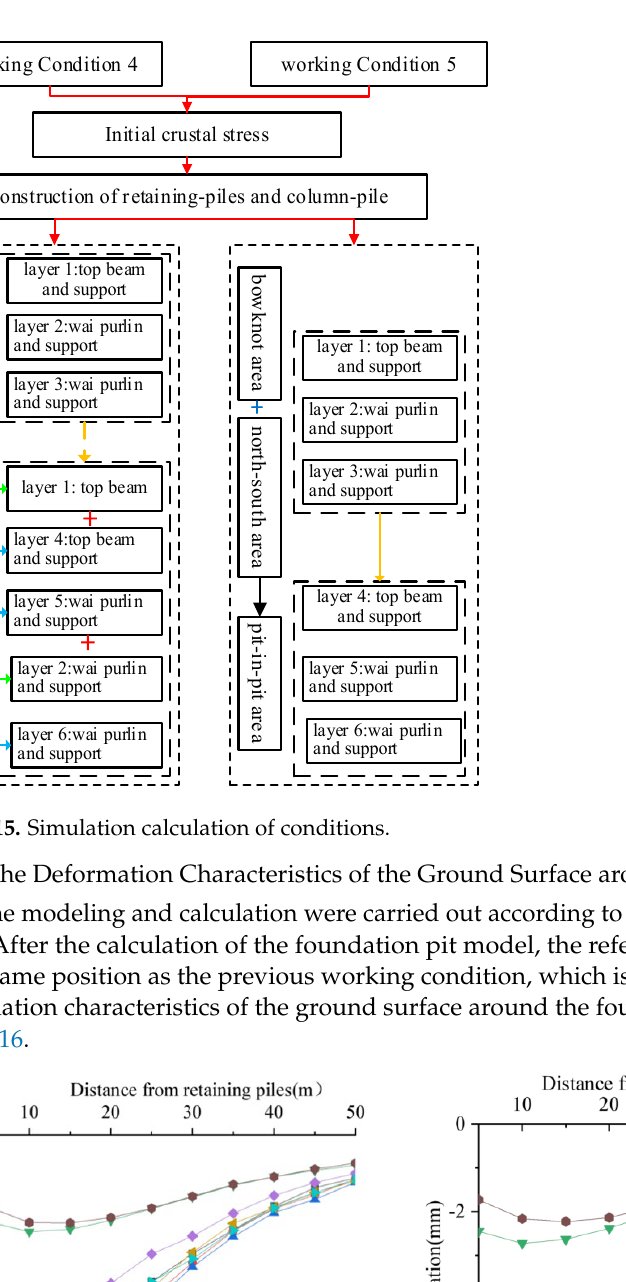
Figure 16. The deformation characteristics of the ground surface. ( a ) working Condition 4. ( b ) work- ing Condition 5.